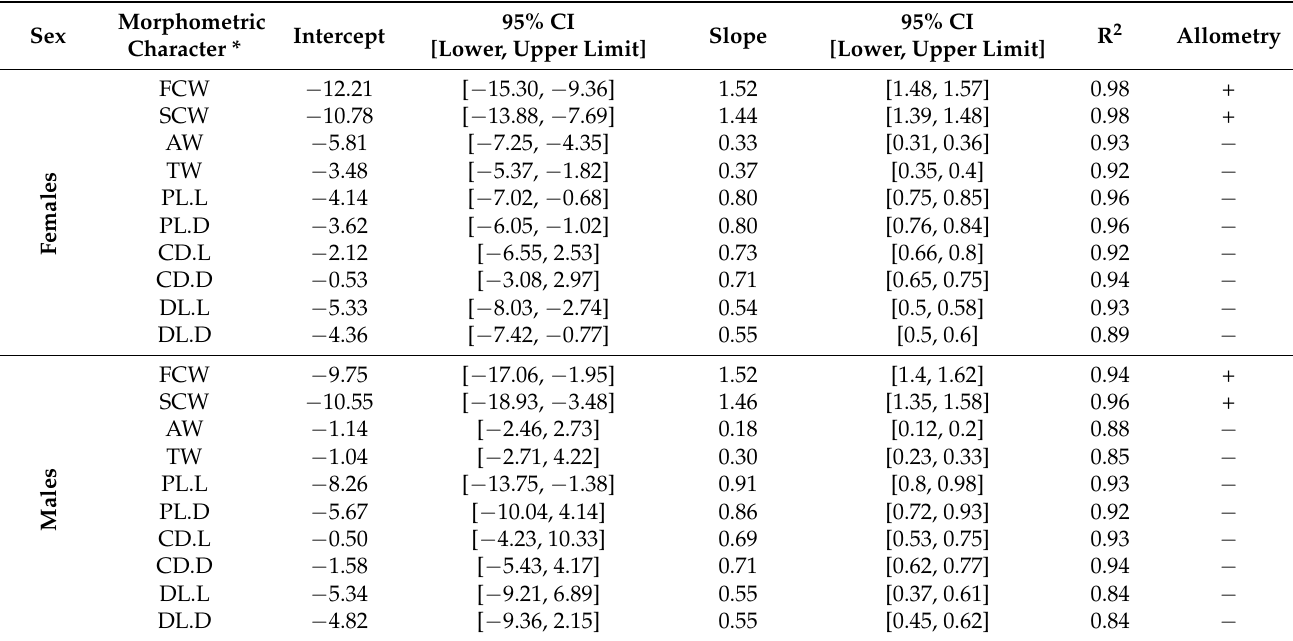
Table 3. Parameters (intercept and slope) of linear regression equations with 95% confidence intervals between different morphometric characters and carapace length of Calappa granulata males and females collected from the central eastern Adriatic Sea.